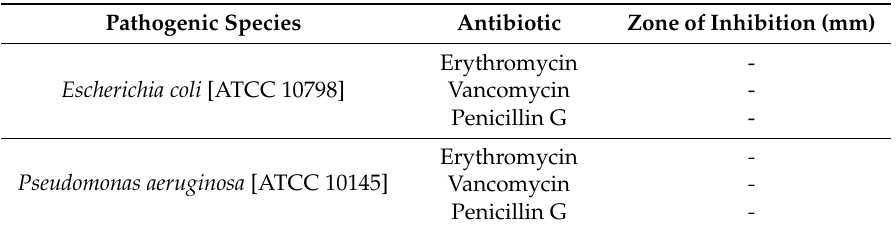
Table 5. Antimicrobial activity of commercial antibiotics against E. coli and P. aeruginosa .